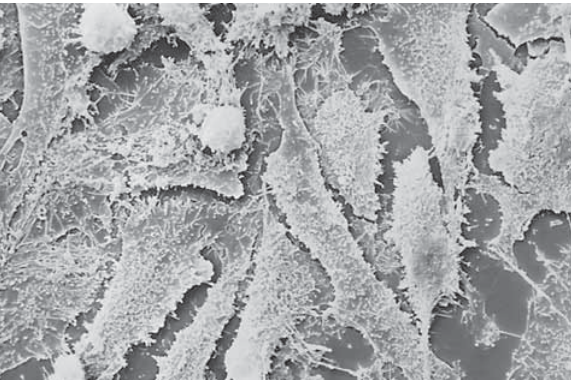
Figure 1- Negative control group (PBS-G5) - Presence of spindle-shaped cells organized in dense nodules and